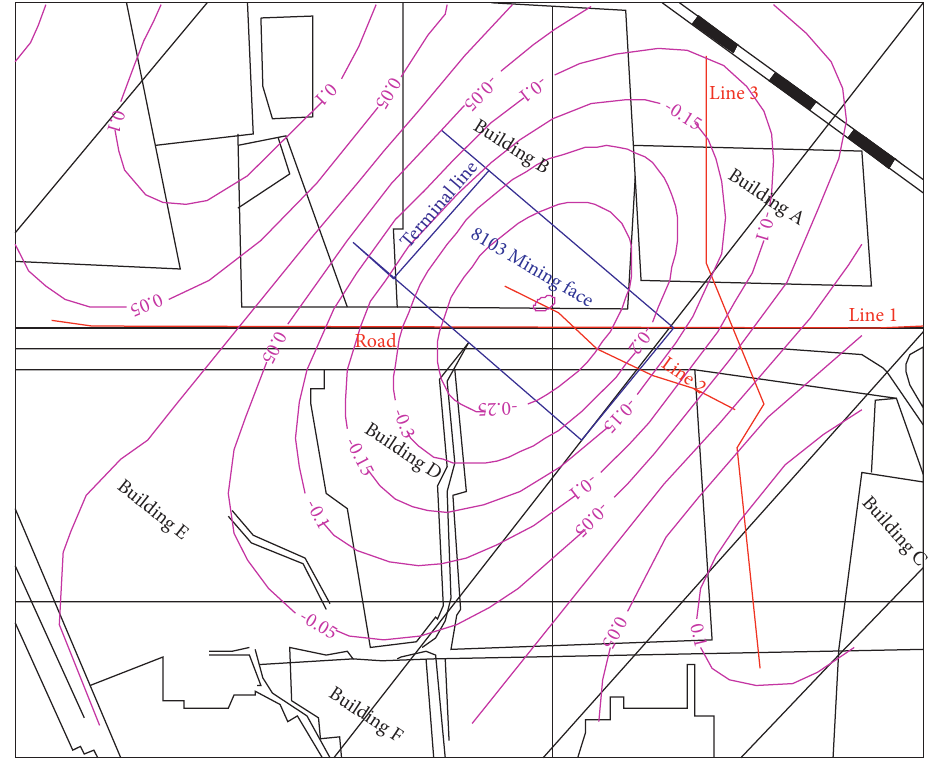
Figure 24: Forecast contour of surface horizontal deformation along strike in 8103 backfilling mining.